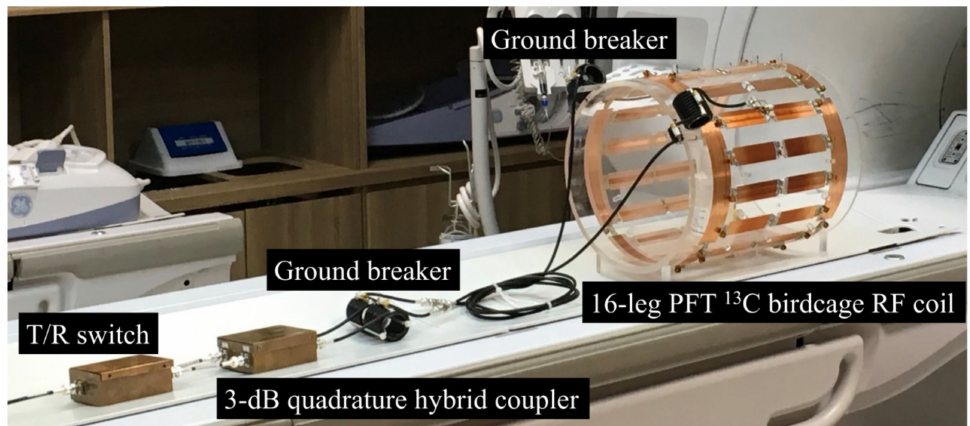
Figure 3. Installed configuration of PFT 13 C birdcage RF coil with CPSCs, ground breakers, 3 dB quadrature hybrid coupler, and T/R switch in a 3.0 T MRI system.